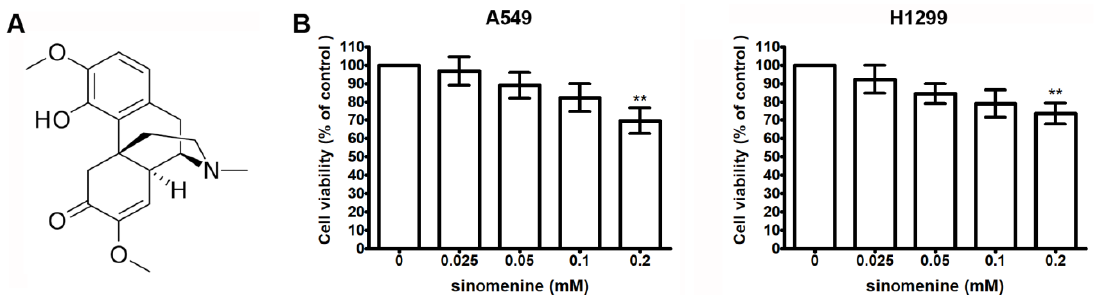
Figure 1. Sinomenine inhibits viability of human lung cancer cells. ( A ) Chemical structure of sinomenine. ( B ) Effect of sinomenine on viability of A549 and H1299 cells. Cells were treated with various concentrations of sinomenine for 24 h. Cell viability is presented as mean ± S.D. of four independent experiments. ** p < 0.01 compared with the untreated control.